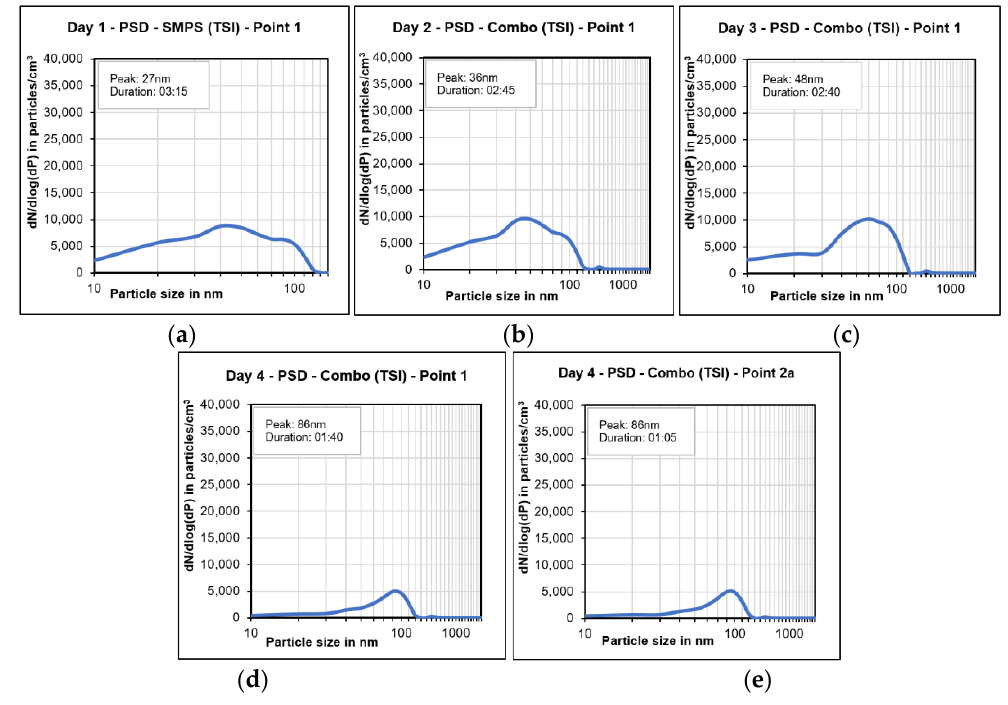
Figure 5. PSD for ( a ) day 1, ( b ) day 2, ( c ) day 3, and ( d , e ) day 4 (phase 1). Beginning in phase 2, a higher number of particles in smaller size classes was observed compared to that in phase 1. On day 9, in which most flight arrivals occurred in phase 2, the maximum number of particles occurred in size classes smaller than 36 nm and there was an increase in the particle number concentration (PNC) to about 12,000 particles/cm 3 , as shown in Figure 6a. On day 10, the same location was measured, but the number of flights per hour decreased from ten to four. The overall PNC was lower at just over 8000 particles/cm 3 , but the peak particle concentration occurred at 27 nm (Figure 6b). The lower peak particle size, compared to that in phase 1, could be caused by the aircrafts influencing the concentrations on the ground, but not very much, due to the few numbers of aircrafts starting and landing in phase 2. ( a ) ( b ) Figure 6. Particle size distributions on ( a ) day 9 and ( b ) day 10 (phase 2). In phase 3, the daily average PSD can be characterized by the peak particle size. Fig- ure 7a–d shows the daily average PSD on days 11, 12, 13, and 14, respectively. On all days when the flight arrivals were measured, the highest particle concentration levels were in the lowest size class of 10 nm, which is the smallest particle size measured by the device. On day 12 (Figure 7b), there were rain prior to the measurements and the particle